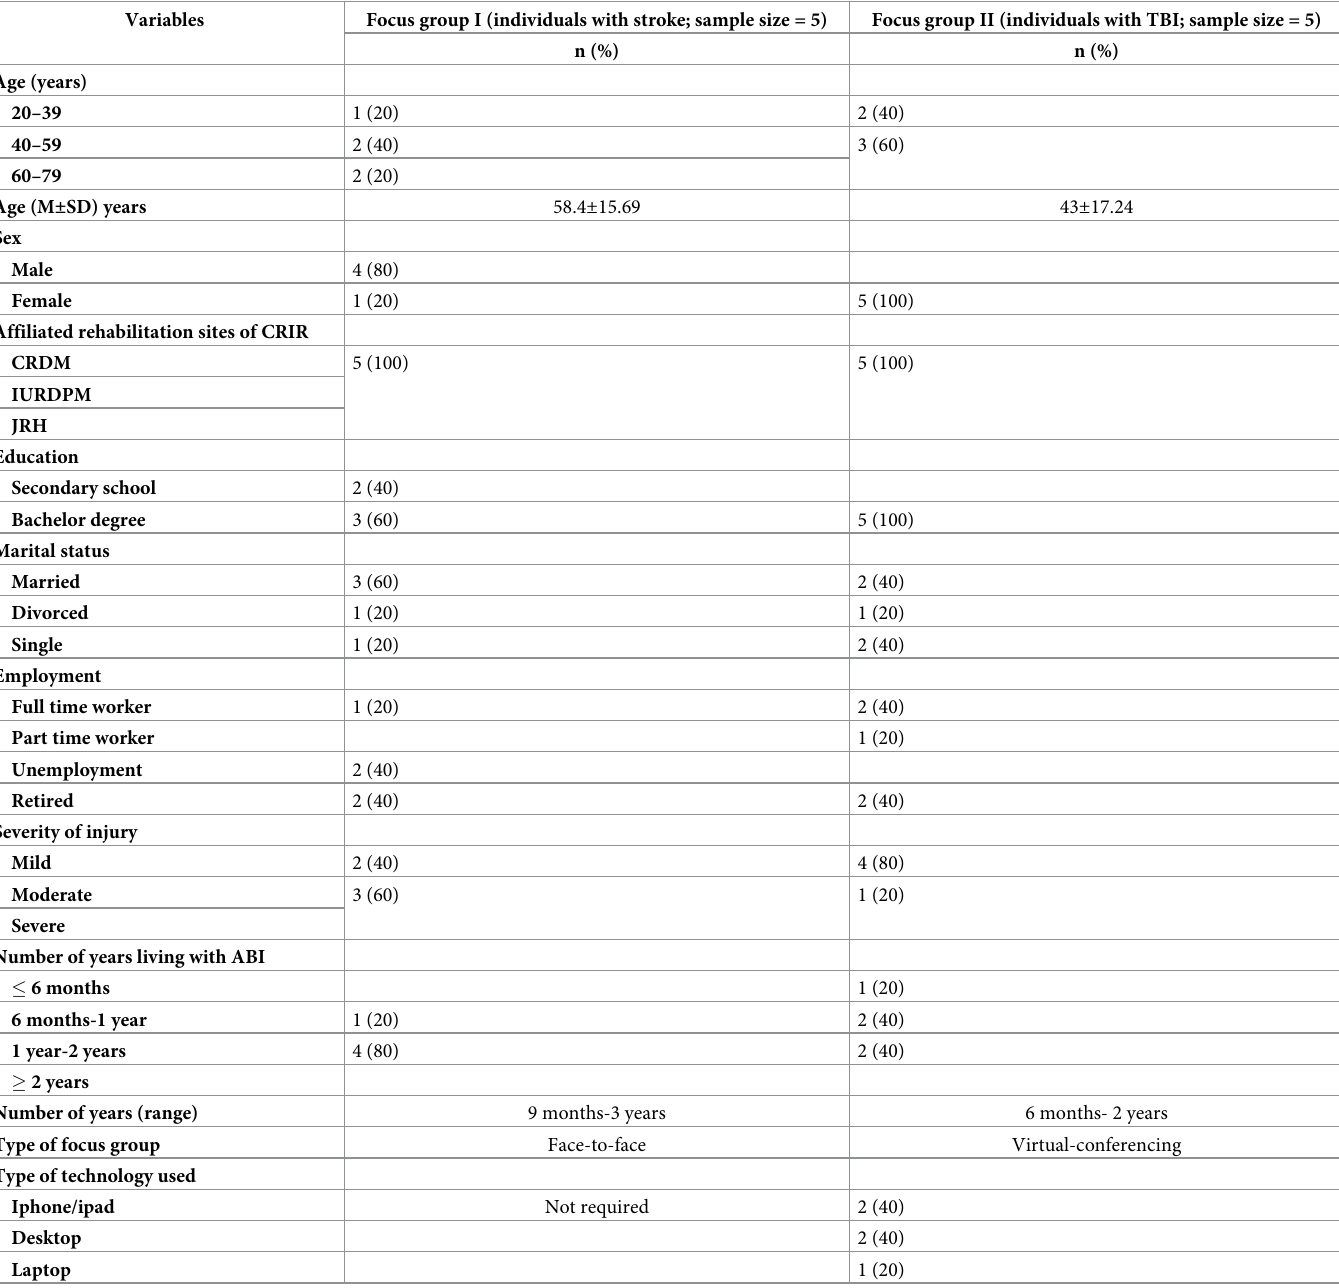
Table 2. Characteristics of the individuals with acquired brain injury.